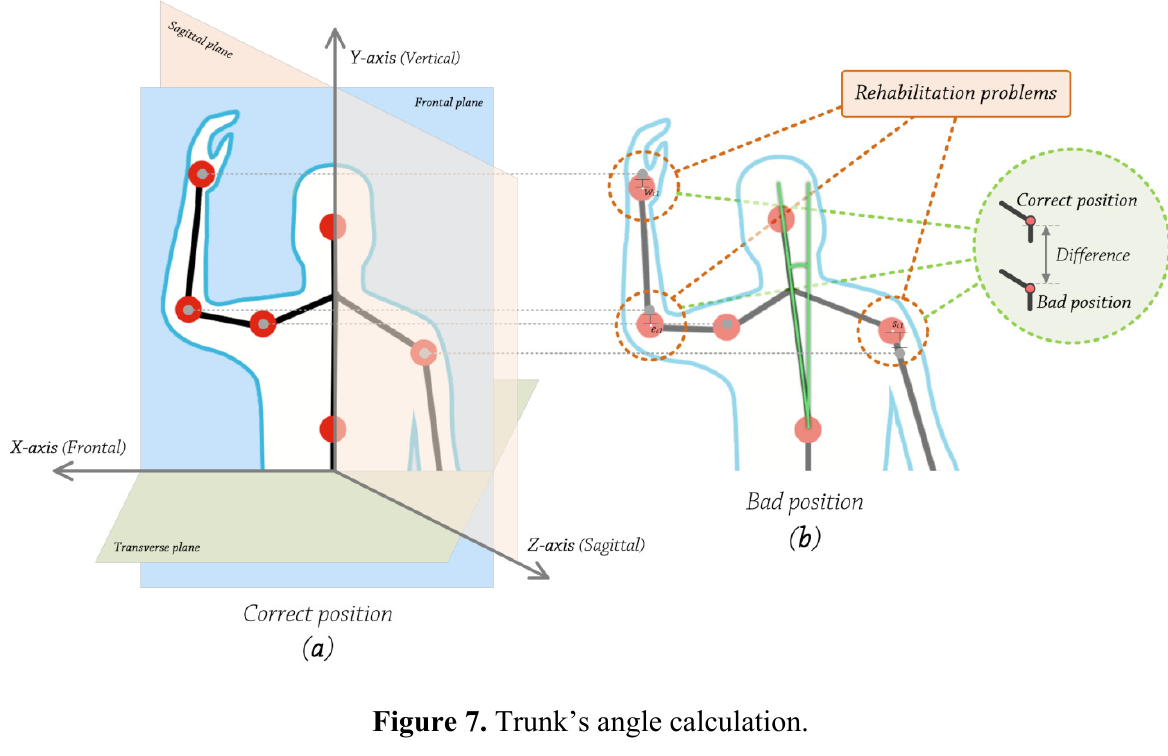
Figure 6. ( a ) Correct position vs. ( b ) Bad position.